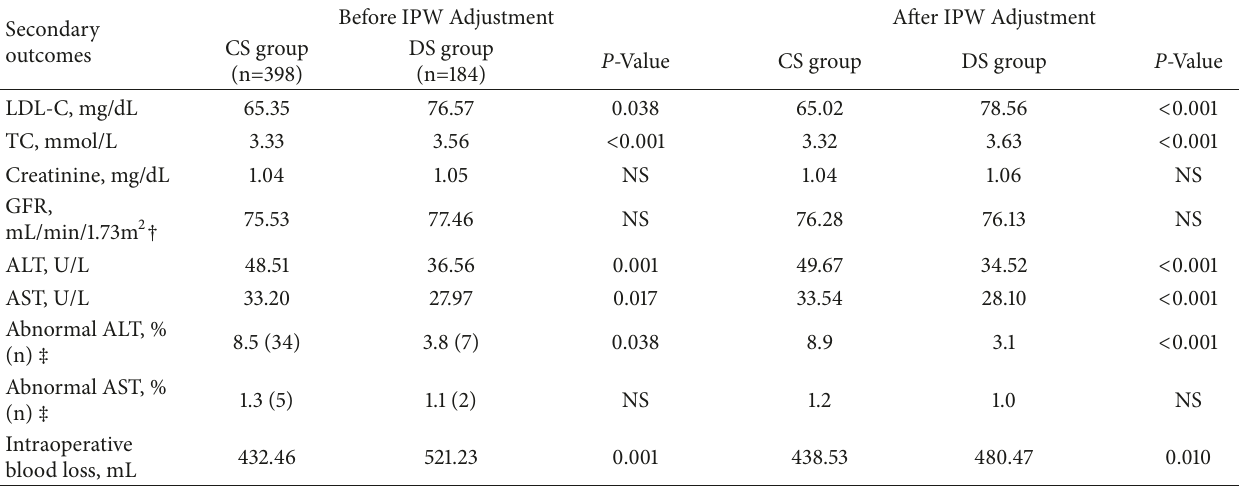
Table 5: Secondary outcomes: effect on liver function and clinical outcomes at